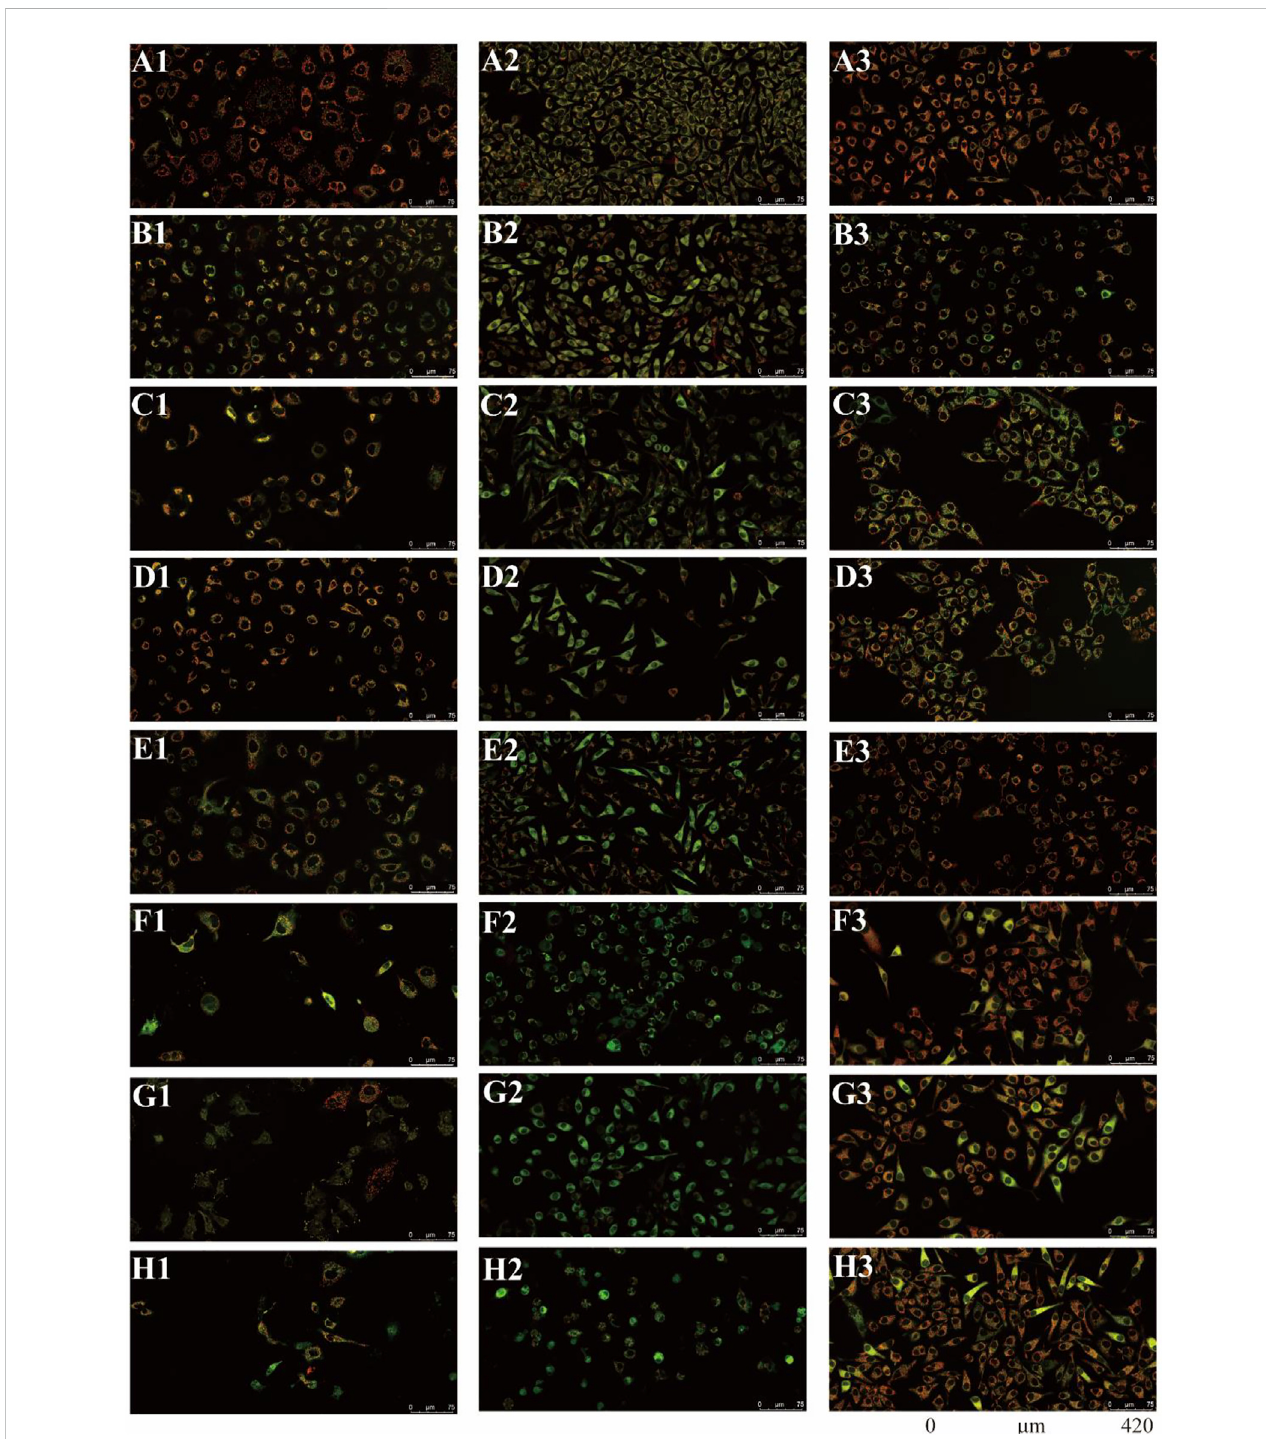
FIGURE 4 Allsixisolatedsaponinsaffectthemitochondrialmembranepotentialofthreecancercelllines.(A1 – H1),A549cells.(A2 – H2),SMMC-7721cells.(A3 – H3), HepG2 cells. Untreated groups served as negative control (An). CCCP-treated groups served as a positive control at 2 μ M (Bn). All saponins were added at a concentration of 2 μ M: saponin 1 (Cn), saponin 2 (Dn), saponin 3 (En), saponin 4 (Fn), saponin 5 (Gn), and saponin 6 (Hn), n = 1, 2,